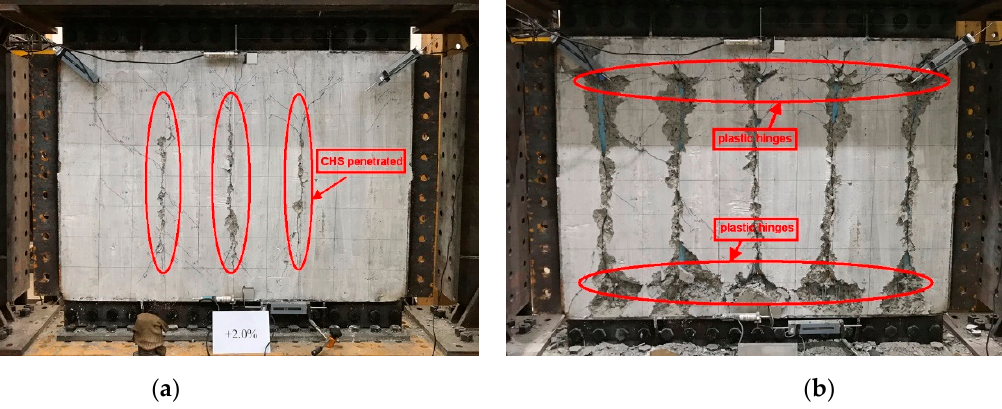
Figure 8. Images of RCIP-3 in different states: ( a ) at a drift ratio of 2%; ( b ) front view after the test. At a drift ratio of 3.5%, the distributed steel rebars were exposed, cover concrete spalling occurred, and the back of the RC panel deformed severely. At a drift ratio of 4%, most of the concrete in the plastic hinge region fell off (Figure 8b). Although the lateral load-bearing capacity of RCIP-3 was high, no visible interface slip was observed during the RCIP-4 also had penetrated slits in its RC panel but with a smaller height-to-span entire loading process. ratio than RCIP-1. Compared to RCIP-1, more extended inclined cracks appeared in the middle of the slit walls of RCIP-4. Under cyclic loads, these extended inclined cracks de- veloped a cross-grid distribution state. The main reason was the small height-to-span ratio of RCIP-4, which caused the specimen to exhibit shear characteristics. Additionally, the foam benzene boards were not removed during testing, which aggravated the damage on the slit walls. At a drift ratio of 1–1.5%, with crack widening and steel-rebar yielding, positive and negative loading directions, respectively (Figure 9a). At a 3.5% drift ratio, the slit walls were split into multiple diamond walls. When the drift ratio reached 4%, the concrete in the cross-grid region fell off, and the vertical steel rebars buckled and were exposed (Figure 9b).